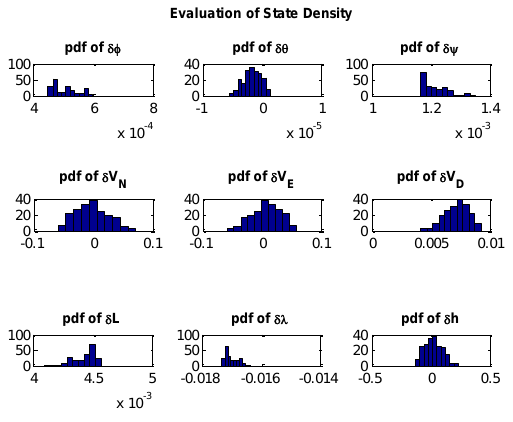
Figure 8. Evaluation of state density.